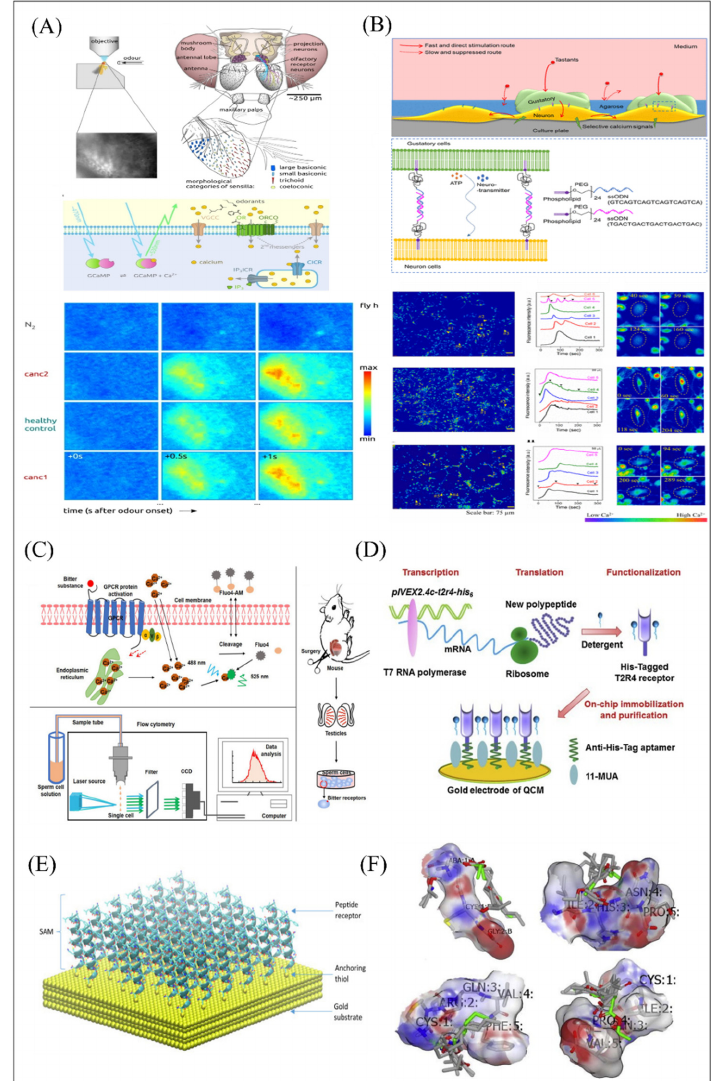
Figure 9. Schematic of biomimetic olfactory and gustatory biosensors based on fluorescence mea- surement. ( A – C ) and QCM ( D – F ) functionalized with different types of sensitive materials and data analysis. ( A ) Schematic mechanism of the calcium imaging principle of the fly’s antenna based on the combination of GCaMP with the increasing Ca 2+ sources induced by odorant stimulus and the spatially different odorant response patterns showed that fluorescence changes in response to odorant stimulation differ for different cancer cell lines. Reproduced with permission from Ref. [120]. ( B ) Schematic illustration of the co-culture system of gustatory-neuron cells with gustatory cells through complementary oligonucleotides for selective taste simulation and the calcium imaging for function verification and concentrations optimizing the agarose thin layer of the co-culture